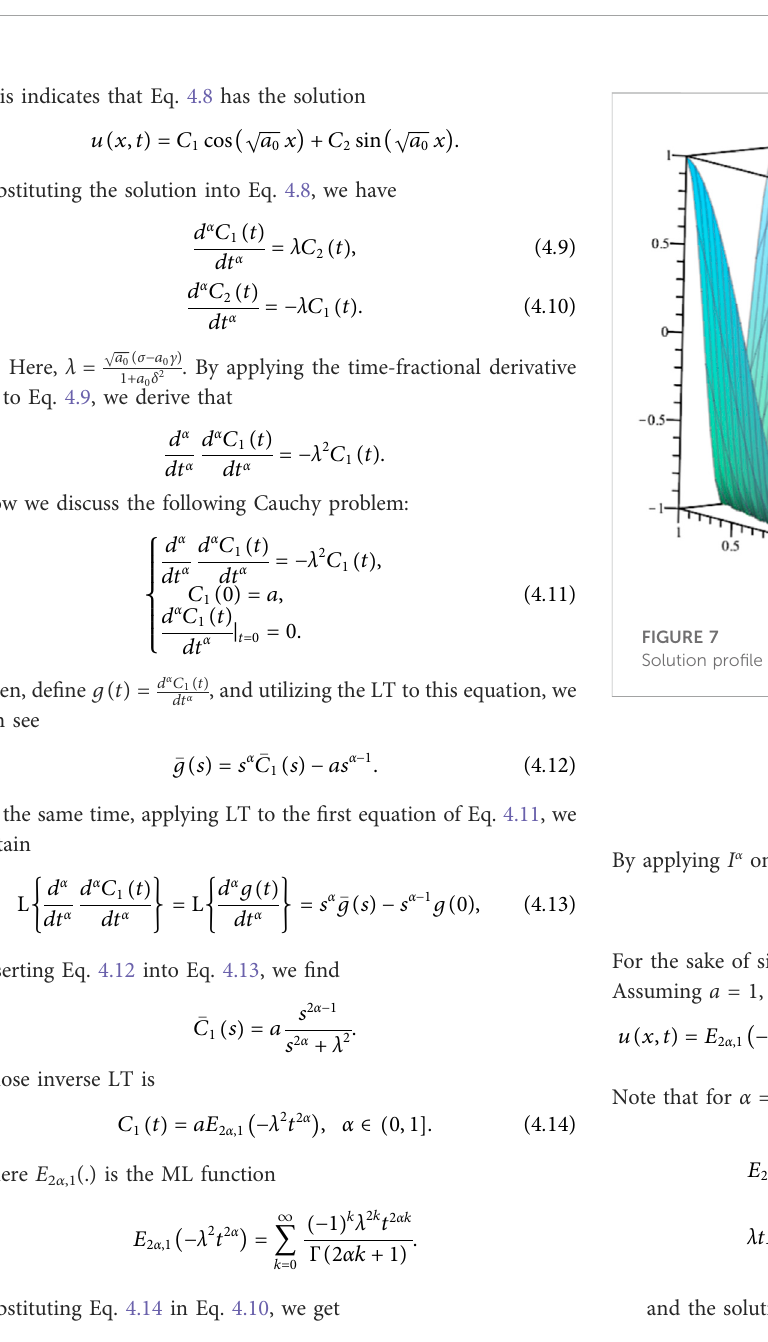
Solution pro fi le of Eq.